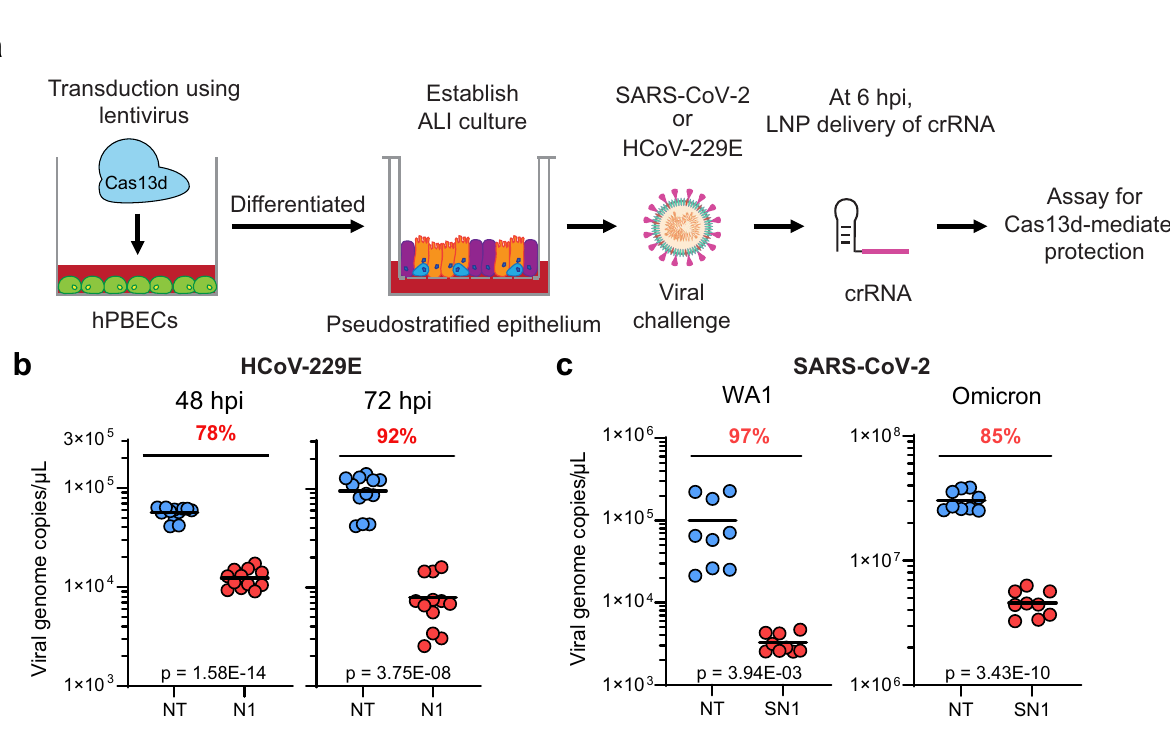
Fig. 6 Cas13d antivirals can treat established viral infection in human primary lung epithelial cultures. a Scheme used for antiviral treatment of air – liquid-interface (ALI) cultures of human primary bronchial epithelial cells (hPBECs). hPBECs were transduced with NES-Cas13d and differentiated to ALI cultures. The ALI cultures were infected with 229E at an MOI of 0.05, with SARS-CoV-2 WA1 at an MOI of 0.6, or with Omicron at an MOI of 0.1. At 6 hpi, the culture was transfected with crRNA using LNP. At 48, 72 hpi, the apical surfaces of ALI cultures were washed with PBS and the wash solution was collected for measuring virus titer. b The titer of 229E virus released on the apical surface of ALI cultures was determined by RT-qPCR; n = 4, t = 3. c The titer of SARS-CoV-2 virus, including WA1 and Omicron strains, was determined at 48 hpi; n = 3, t = 3. n is the number of independent biological experiments. t is the number of technician replicates per biological replicate in the RT-qPCR assay. All source data in this fi gure are provided as a Source data fi le. P values are listed in supplementary Data 3, calculated by two-tailed Student ’ s t